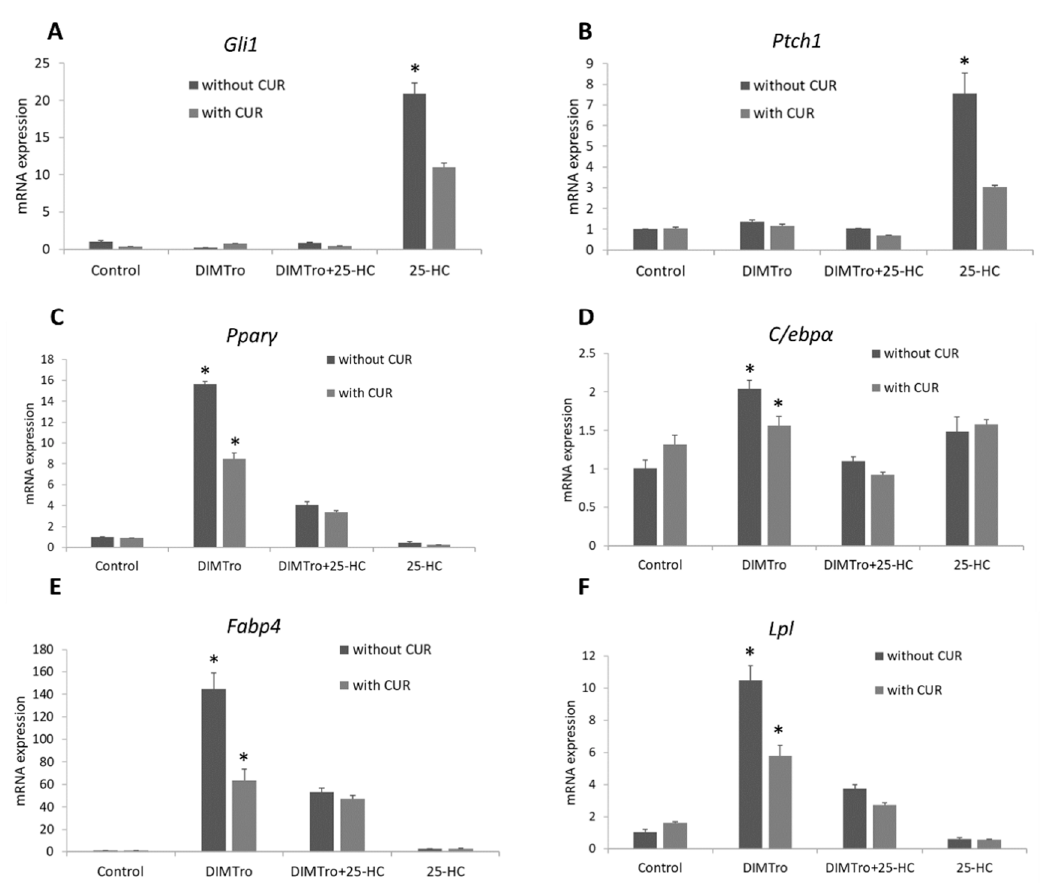
Figure 8. mRNA expression of hedgehog signalling genes: Gli1 ( A ) and Ptch1 ( B ); adipogenic genes: Ppar γ ( C ), C / ebp α ( D ), Fabp4 ( E ) and Lpl ( F ), in C3H10T1 / 2 cells treated with a control, DMITro, DMITro + 25-HC or 25-HC, with or without CUR61414 for 96 h. The results show the average value of three replicates ( n = 3) and the SD of the means. Bars with * in figure ( A , B ) show significant di ff erence between 25-OH treatments with / without CUR61414 ( p < 0.05); Bars with * in figure ( C – F ), show significant difference between DMITro and DMITro + 25-OH regardless of CUR61414 treatments ( p < 0.05).